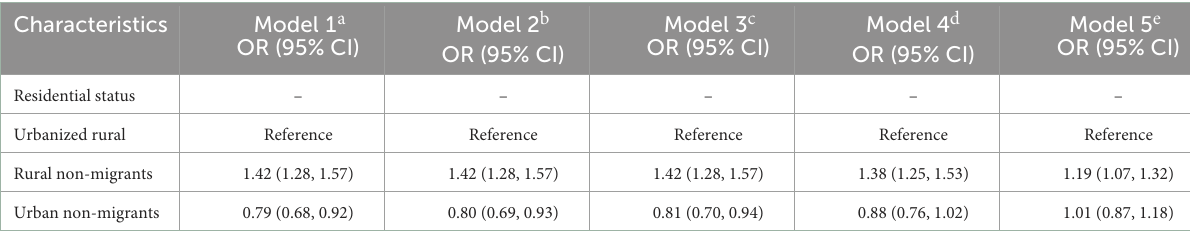
TABLE 2 Logistic regressions of the association between residential status and the risk of depressive symptoms ( N =